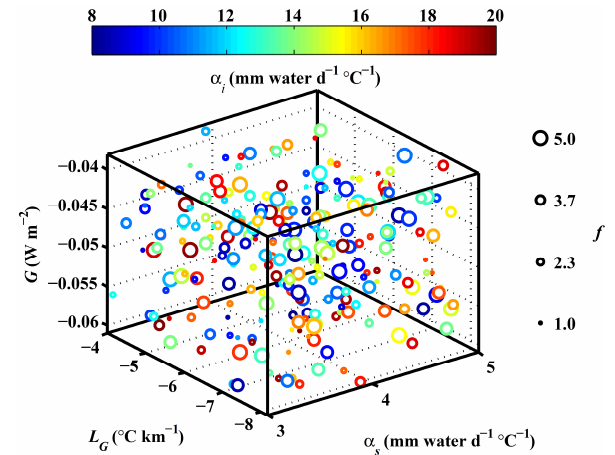
Figure 6. Distribution of 250 experiments produced by Latin-Hypercube Sampling. In three dimensions geothermal heat flux ( G ), PDD factor for snow ( α s ) and atmospheric vertical lapse rate ( L G ) are shown. In addition, for each experiment the PDD factor for ice ( α i ) is shown in terms of the colour-scale and the enhancement flow factor ( f ) in terms of the size of circle.